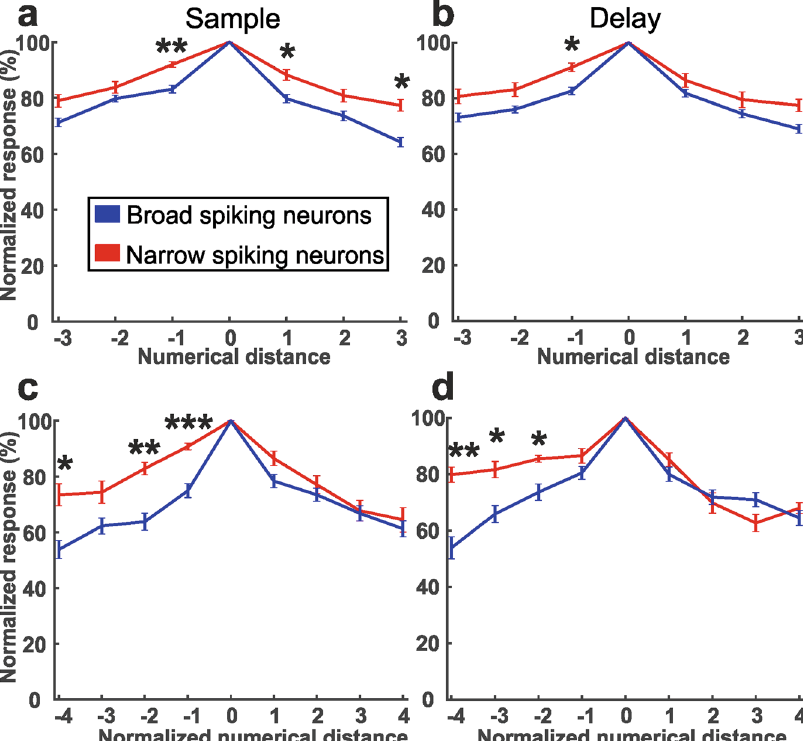
Fig. 5 Population-tuning curves of NS (red) and BS (blue) neurons. a, c Population-tuning curves of neurons that were numerosity-selective during the sample period and that responded to small (1 – 4 and 1 – 5 pooled) numerosities ( a ) or large (1 – 30) numerosities ( c ). b, d Population-tuning curves of neurons tuned in the delay period and that responded to small numerosities ( b ) or large numerosities ( d ). For large numerosities, the distances between the tested numerosities are treated as having distance 1. Error bars indicate SEM. * p < 0.05, ** p < 0.01, *** p <